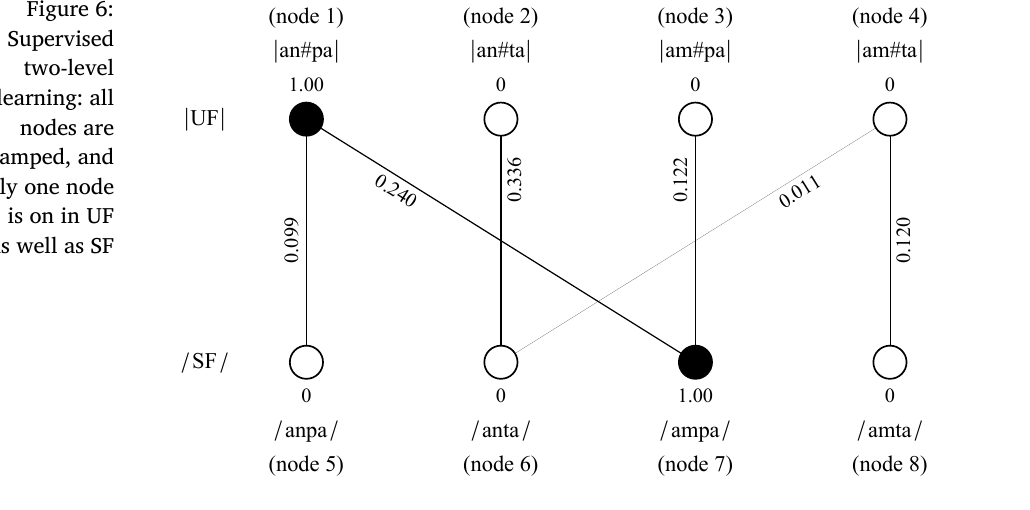
Figure 6: Supervised two-level learning: